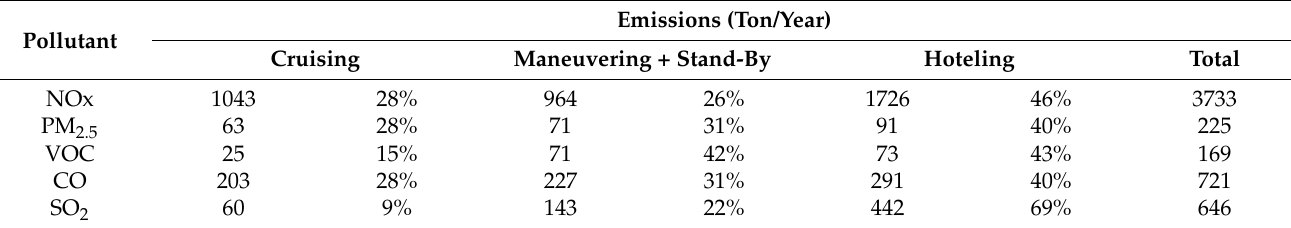
Table A24. Total emissions from vessels (Ashdod, MPS A1 2030).